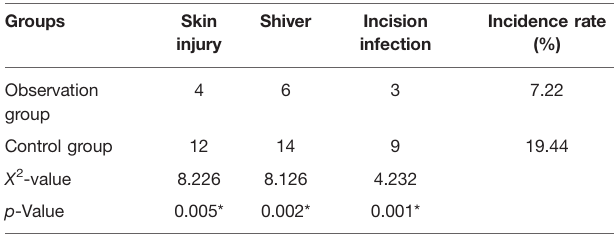
TABLE 1 | Comparison of postoperative complications between two groups ( n =360, %). Groups